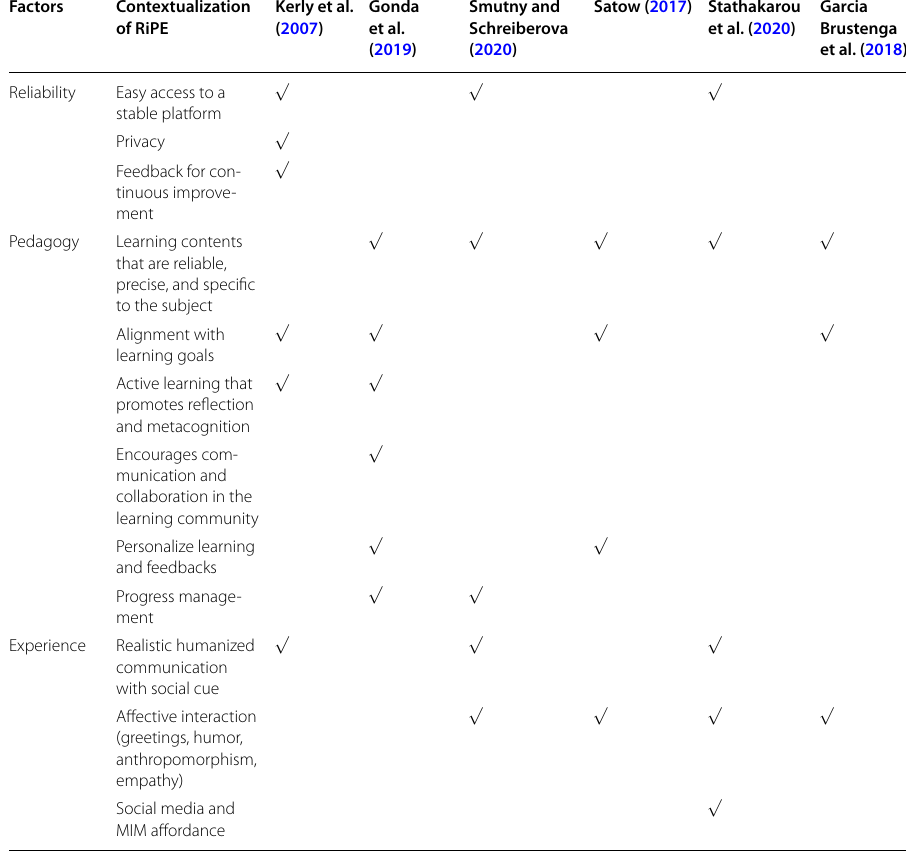
Table 2 EC design strategies from empirical findings Factors Contextualization of RiPE